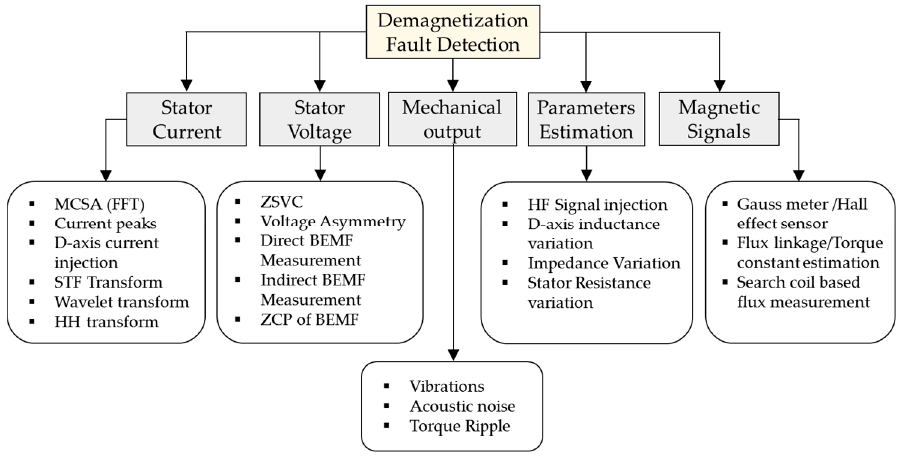
Figure 6. Summary of different fault index categories and their subcategories for IDF.